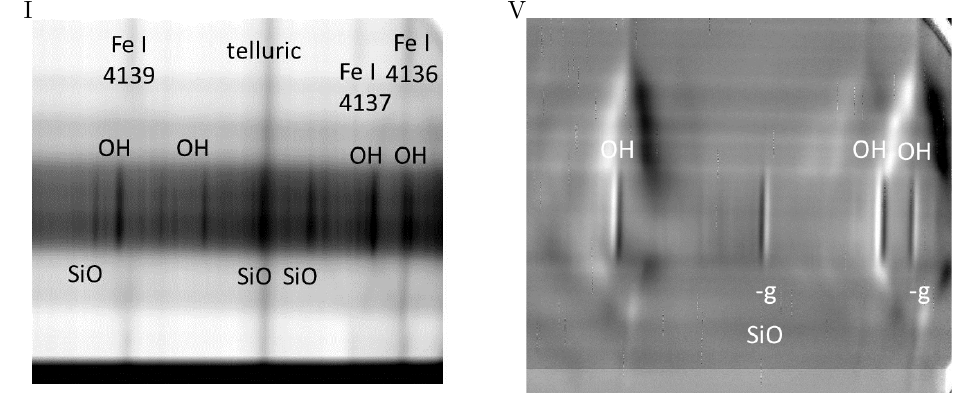
Figure 26: Stokes I and V profiles for several atomic and molecular lines near 4135 nm from NAC data taken at the McM-P telescope. Credits: